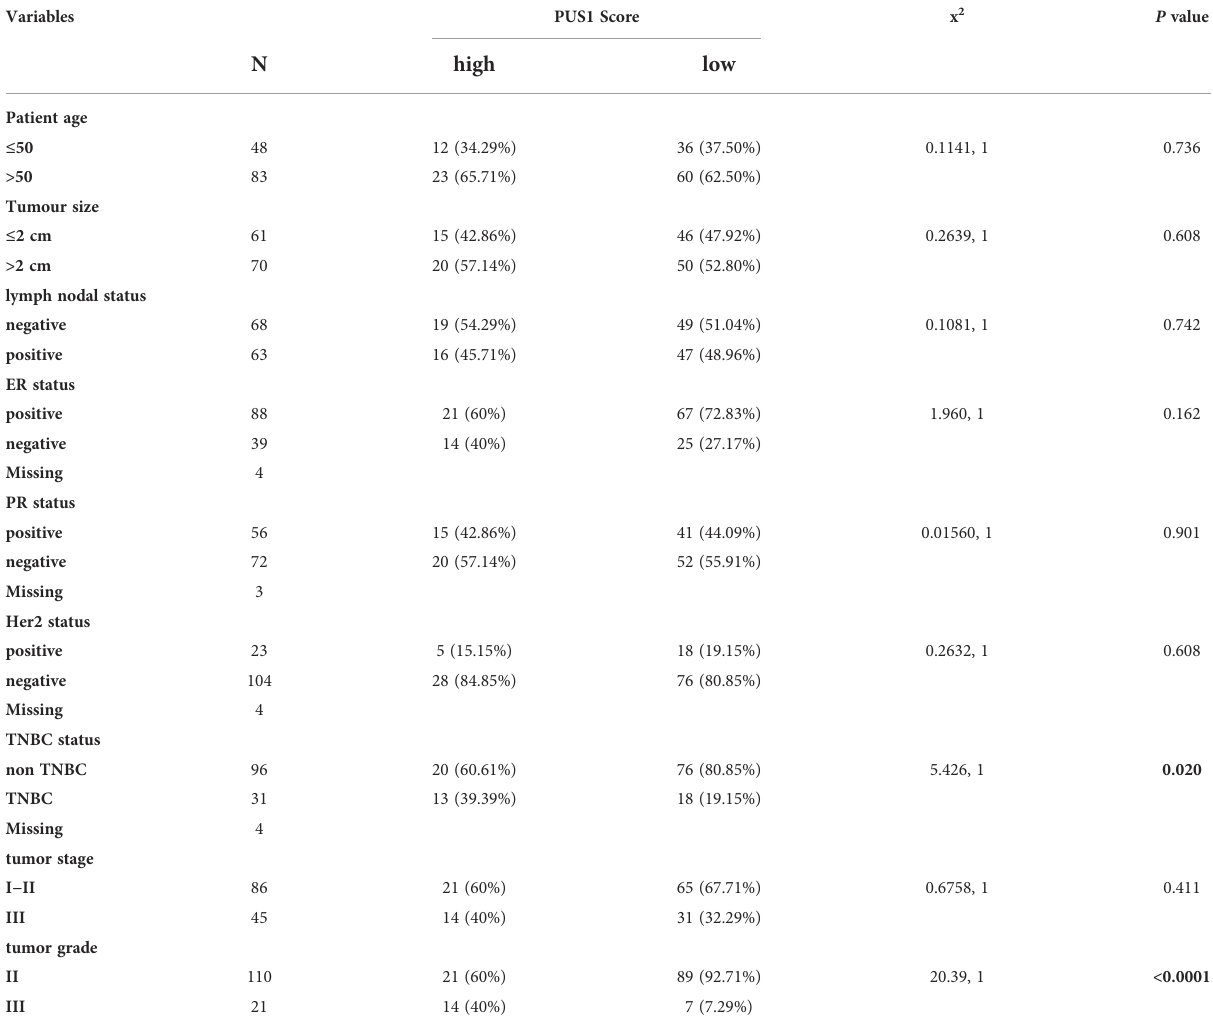
TABLE 1 Clinicopathological associations of PUS1 IHC score.